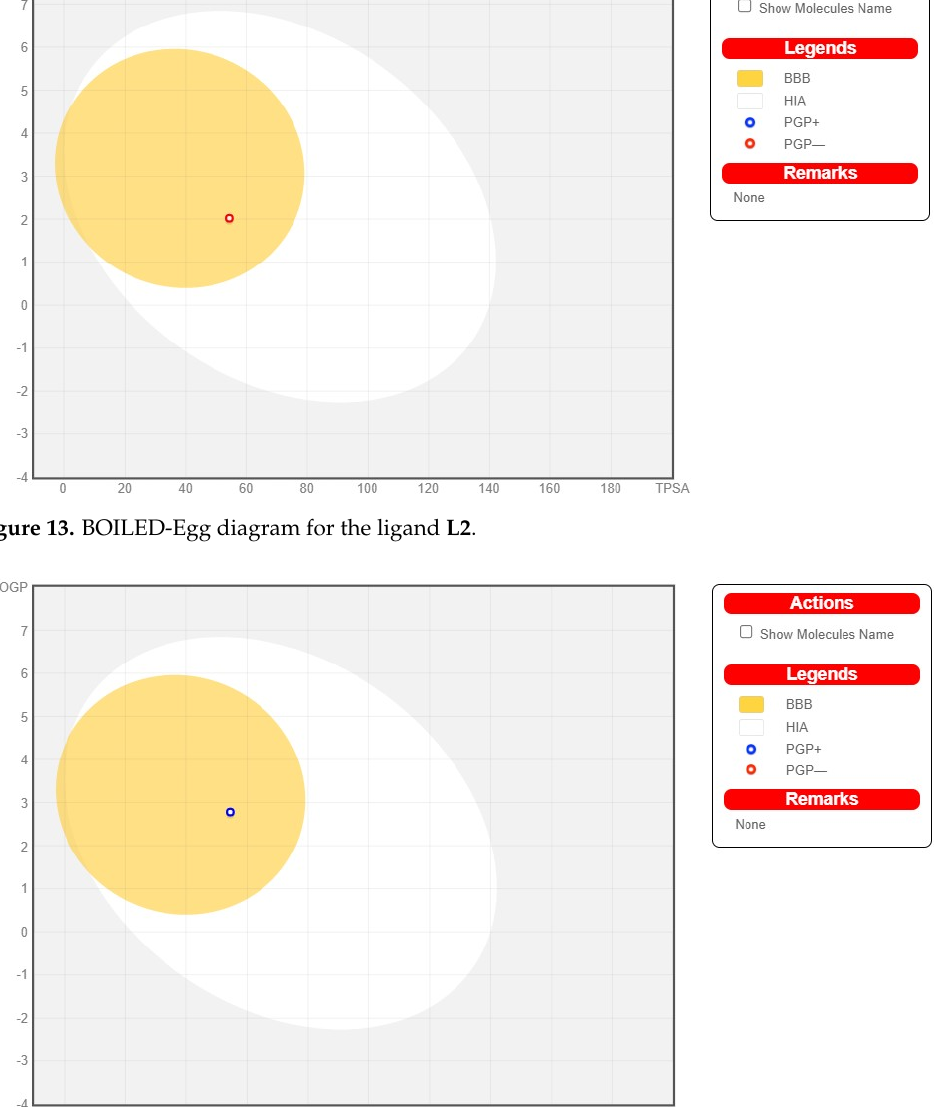
Figure 14. BOILED-Egg diagram for the ligand L4 .